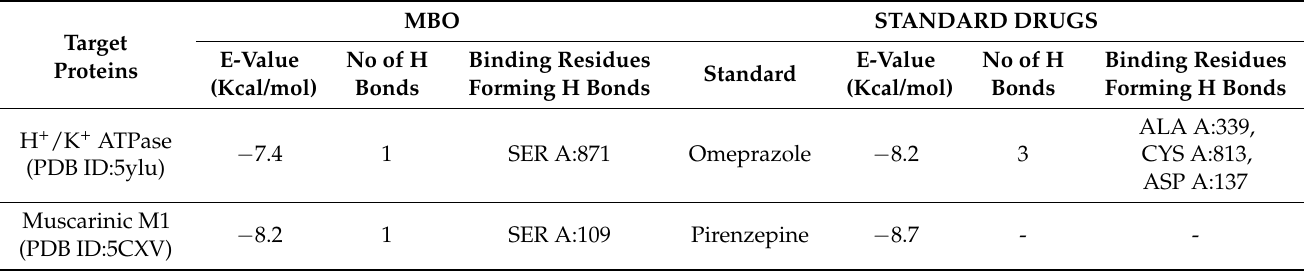
Table 2. E-values (Kcal/mol) and post-dock analysis of best pose of MBO and standard drugs with